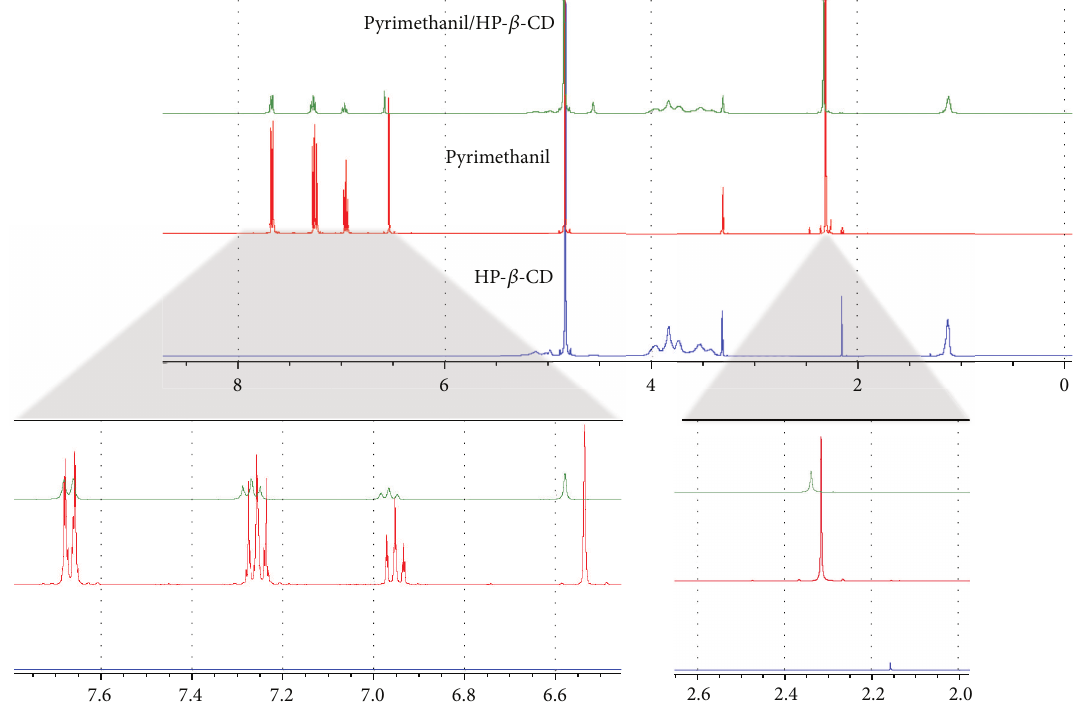
Figure 3: 1 H NMR spectra of pyrimethanil, HP- 𝛽 -CD, and pyrimethanil/HP- 𝛽 -CD inclusion complex.